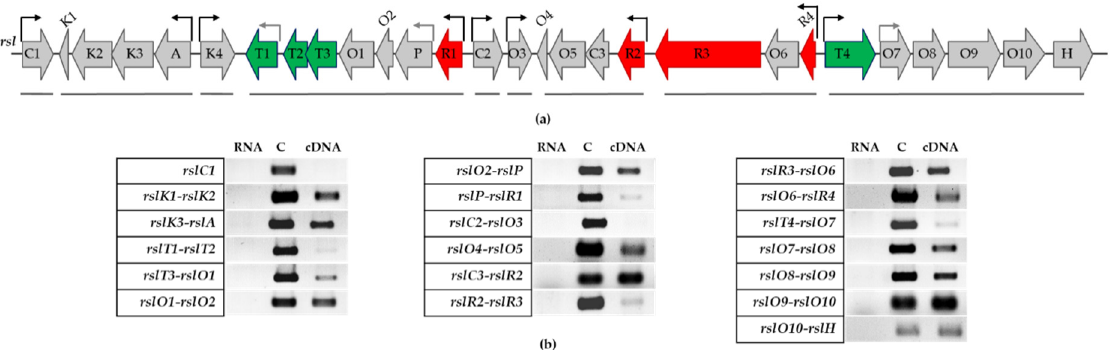
Figure 3. Transcriptional organization of rsl -genes. ( a ) Genetic organization of the rishirilide gene cluster. Regulatory, biosynthetic, and transporter genes are highlighted in red, grey, and green, respectively. The solid lines under the genes depict transcriptional units, black bent arrows are promoter regions, grey bent arrows are putative promoters; ( b ) RT-PCR analysis of rsl -genes co-transcription. RNA, genomic DNA (C), and cDNA were used as a template in PCR reactions. The functions of rsl -genes are described in [30,33,35].